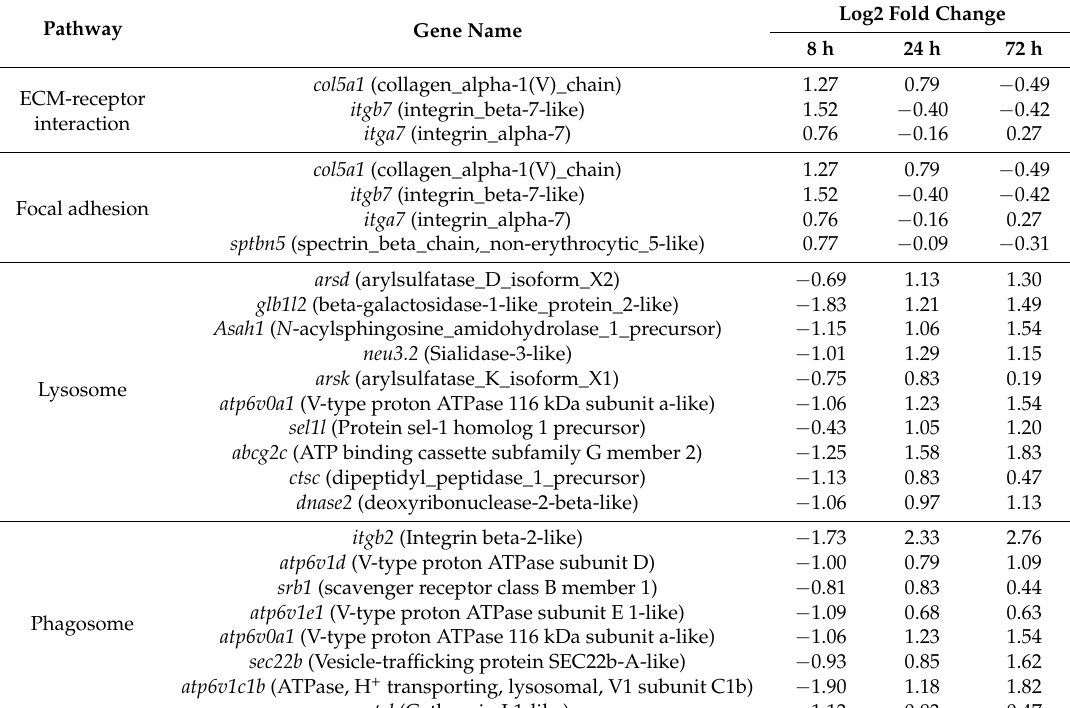
Table 5. DEGs associated with four major